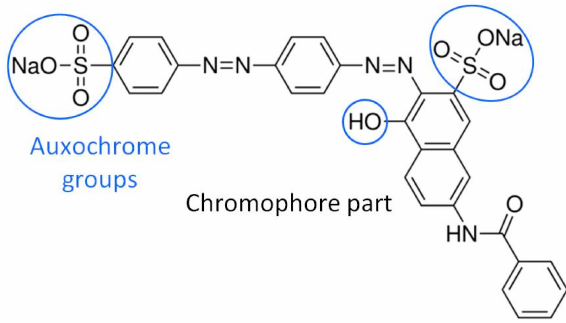
Figure 1. Molecular structure of Direct Red 81 dye.